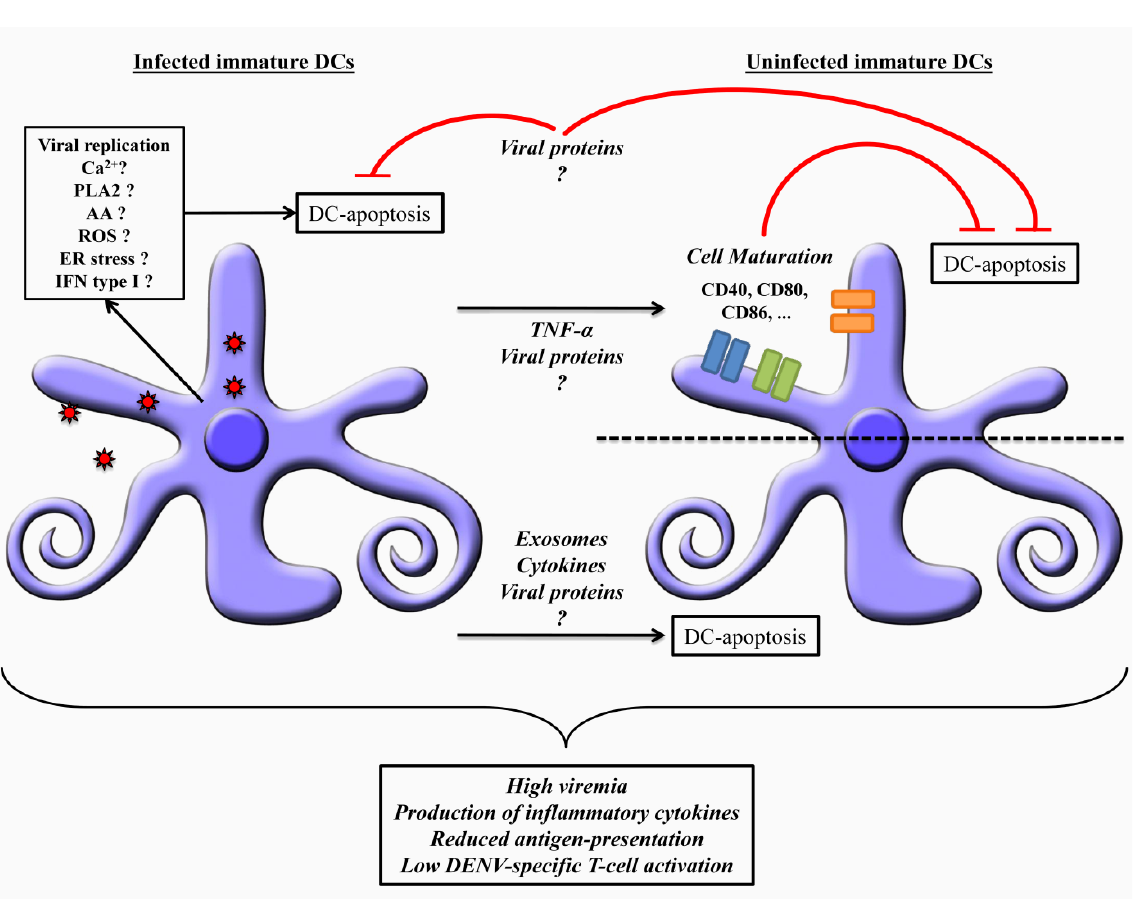
Figure 2. Possible mechanisms by which dengue virus may induce apoptosis of Dendritic cells (DCs). Dengue virus (DENV) can directly induce DC-apoptosis through replication inside infected cells. Apoptosis may also be induced in infected and uninfected-DC via exosomes, cytokines and viral proteins secreted from infected DCs. It has been demonstrated that TNF- α protects DCs from ap optosis induced by DENV, possibly inducing DC maturation. Also, structural and non-structural viral proteins may either induce apoptosis or protect DC from apoptosis. Finally, induction of apoptosis by DENV in infected and uninfected DC presumably contributes to dengue pathogenesis by promoting high viremia, production of inflammatory cytokines, reduced antigen-presentation and low DENV-specific T-cell